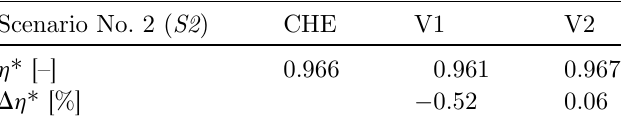
Table 3. The weighted hydraulic ef fi ciency for each solution and the ef fi ciency gain with respect to the existing one in scenario No. 2 ( S2 ).